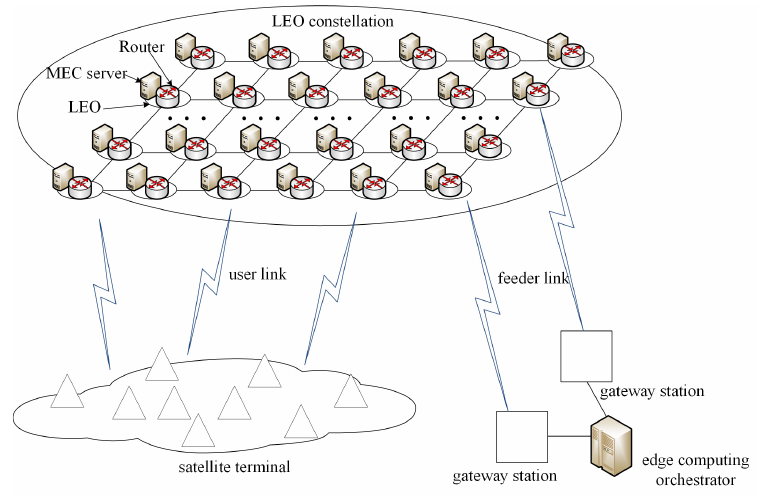
Figure 2. The LEO-ECN